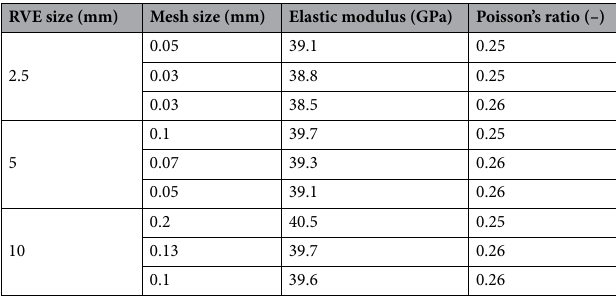
Table 3. Elastic properties based on RVE and mesh size at mesoscale.